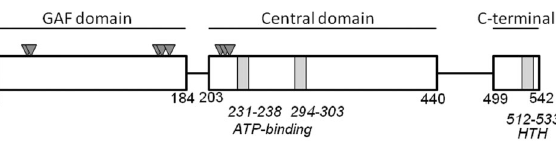
Figure 1. Scheme of Herbaspirillum seropedicae NifA domains. Numbers indicate the amino acid position on the primary structure. The N-terminal GAF domain, central domain, and C-terminal domain are indicated as open rectangles. The ATP-binding motifs, located in the central domain, and the helix-turn-helix (HTH) motif in the C-terminal domain are indicated as gray rectangles, and were predicted using the ScanProsite tool (http://prosite.expasy.org/scanprosite) (29) and Gym2.0 (30), respectively. Point-mutations (K22V, G25E, T160E, M161V, L172R, A215D, Q216I, and S220I) are indicated by gray triangles in the N-terminal GAF and central domains of